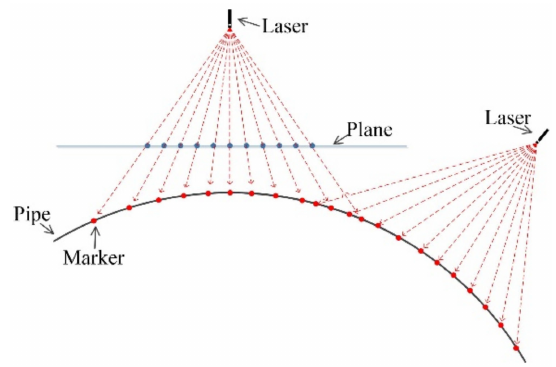
Figure 5. Laser markers